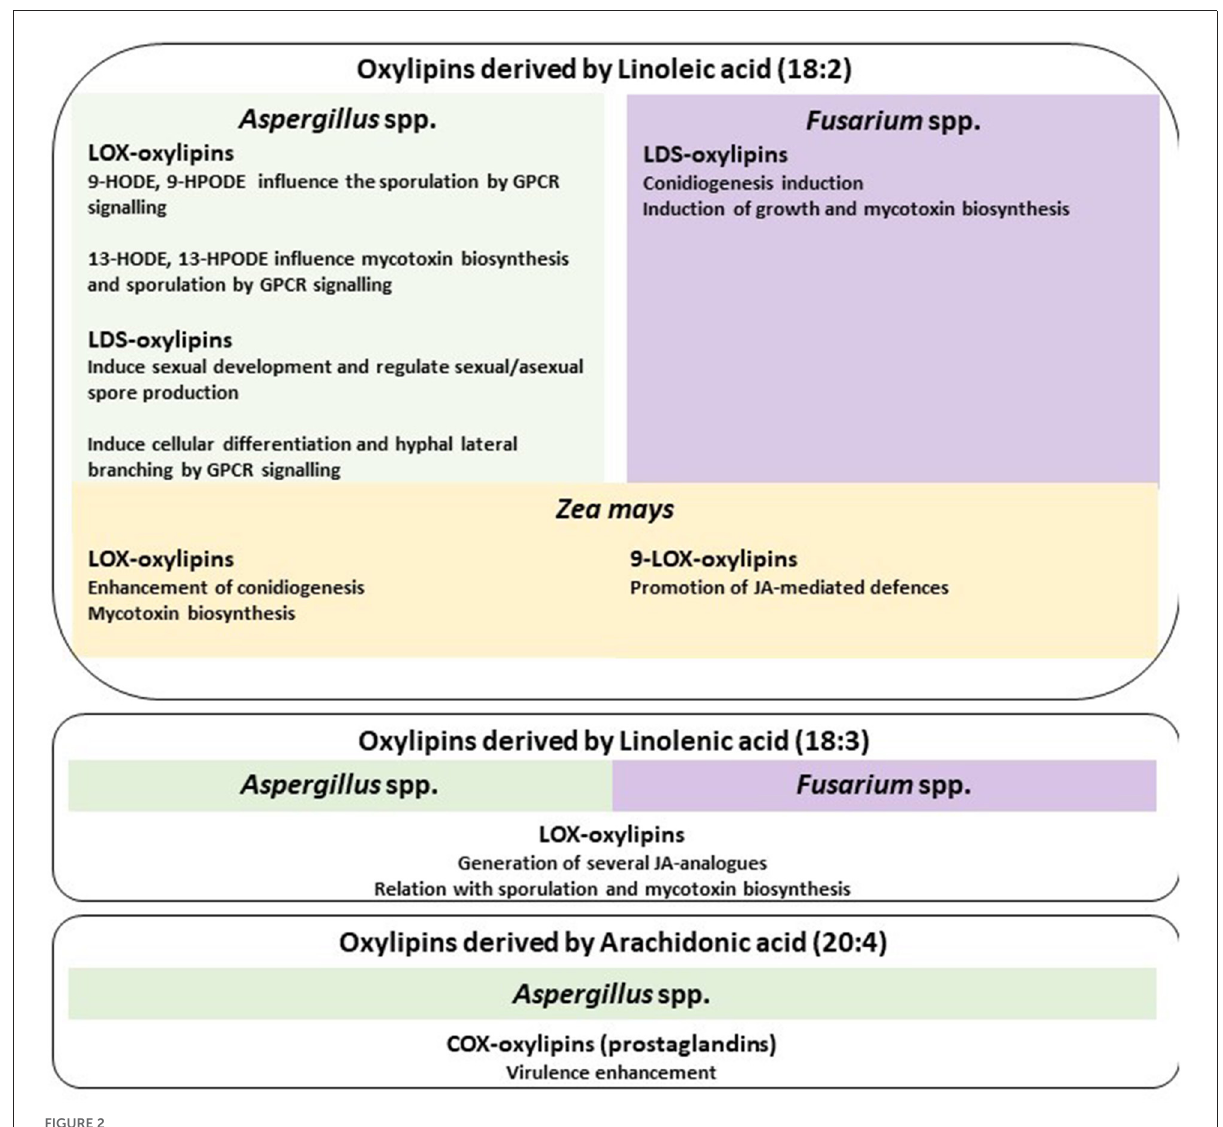
FIGURE2 Oxylipin functions. Linoleic acid-derived oxylipins are described for Aspergillus spp., Fusarium spp., and maize. For Aspergillus spp., the main signaling process mediated by lipoxygenases (LOX) and linoleate diol synthases (LDS) is reported, for Fusarium spp. is described the LDS involvement, and for maize the LOX-mediated functions. Linolenic acid oxylipins derived from LOX activity shared the same functions in Aspergillus spp. and Fusarium